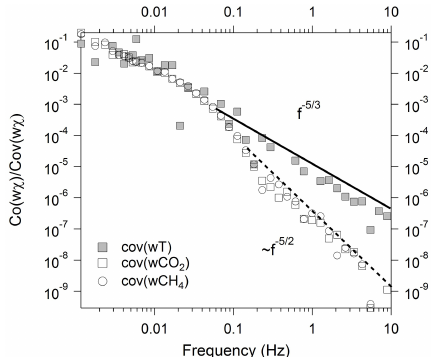
Figure 1. Normalized cospectra of T (sonic temperature), CO 2 and CH 4 with respect to w (vertical wind component). Each cospectrum is an average of 24 half-hourly cospectra (data period 12 March 2013 07:00–18:00). Regression of spectra for frequencies > 0.1Hz marked by solid line for Co(w T ) and dashed line for both Co(wCO 2 ) and Co(wCH 4